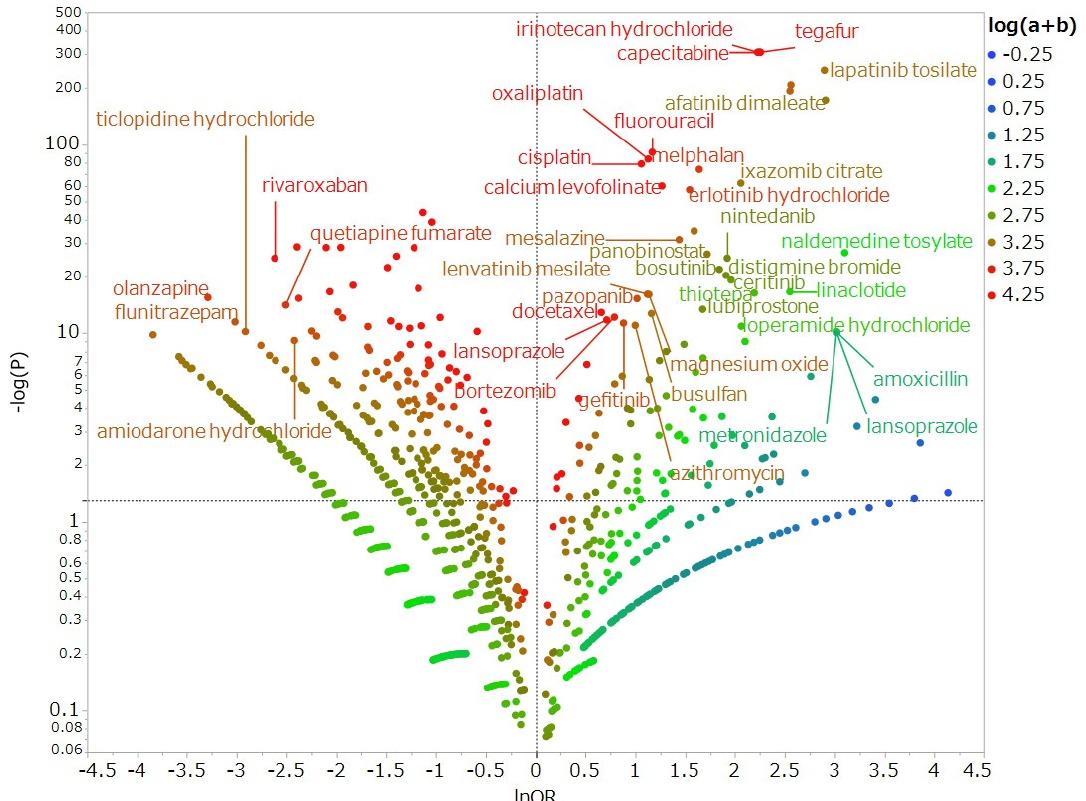
Figure 1. Drugs associated with the development of diarrhea. The X-axis shows natural logarithm of odds ratio (lnOR) values, whereas the Y-axis shows common logarithm of inverse p -values ( − log10 ( p )) obtained by Fisher’s exact test. The dotted line on the Y-axis represents a p -value of 0.05. Plot colors represent the number of reported adverse events. Blue, green, and red dots are common logarithms of total reported numbers (from − 0.25 to